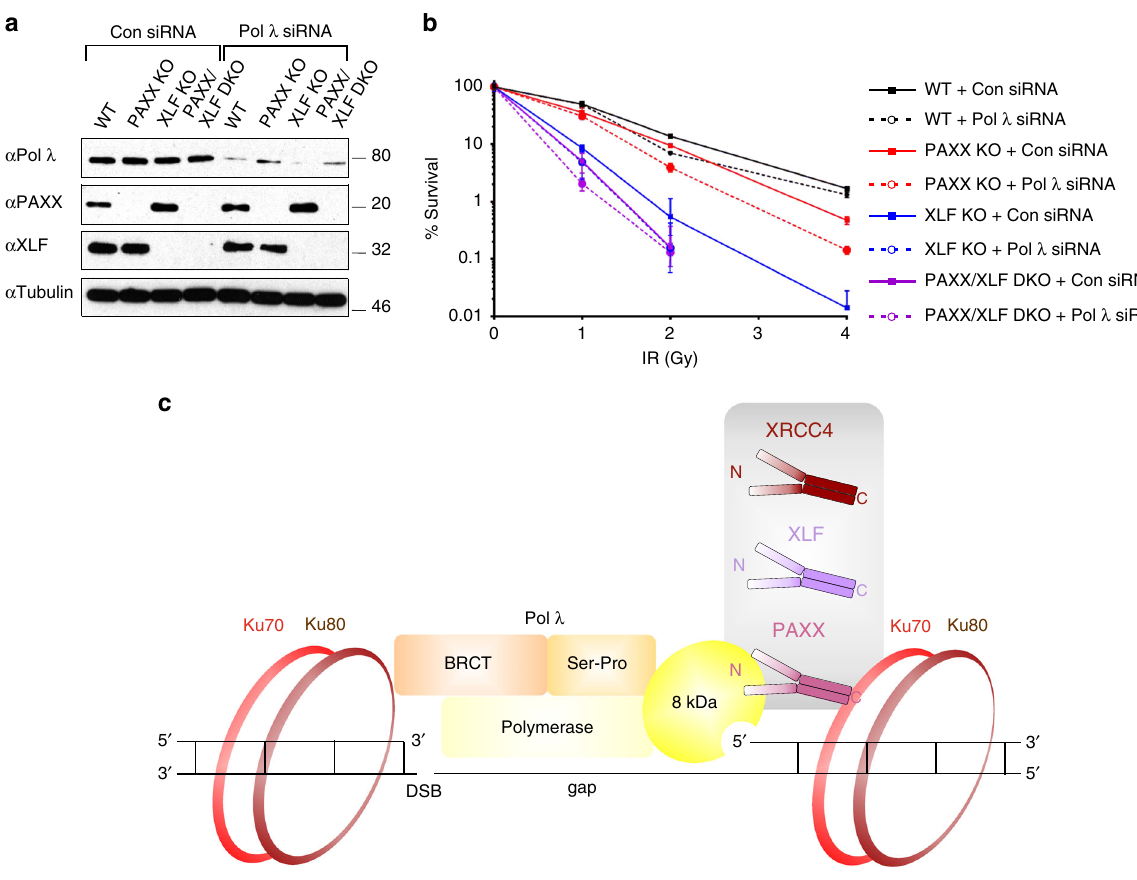
Fig. 10 Pol λ , PAXX and XLF function in common and parallel pathways. a Immunoblot analysis of control- or Pol λ siRNA-depleted U2OS PAXX KO, XLF KO and PAXX/XLF DKO cells. WCL were resolved by SDS-PAGE and indicated proteins detected by immunoblotting. b Clonogenic survival assays following IR (0-4 Gy) for U2OS WT, -PAXX KO, -XLF KO and -PAXX/XLF DKO cells with or without depletion of Pol λ Mean and SD from three independent experiments are shown. Statistical analysis was performed using a two-tailed paired t-test to compare cells incubated with Pol λ siRNA with control siRNA: 1 Gy - WT p = 0.91, PAXX KO p = 0.38, XLF KO p = 0.10, PAXX/XLF DKO p = 0.10; 2 Gy - WT p = 0.0003, PAXX KO p = 0.0007, XLF KO p